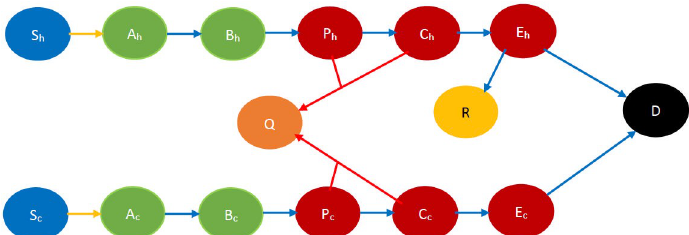
Fig 2. Smallpox disease progression overview for “drug only” scenario. The state in orange color denotes the preempted state. The red arrows denote preemption via drugs. Every other state and transition has the same meaning as described in the caption for Fig